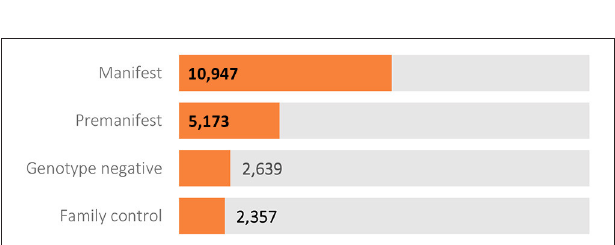
FIGURE 3 | Geographical distribution of Enroll-HD participants ( N = 21,116).